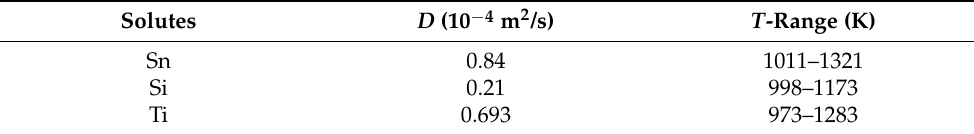
Table 5. The diffusion coefficients of different solutes in pure copper [22].